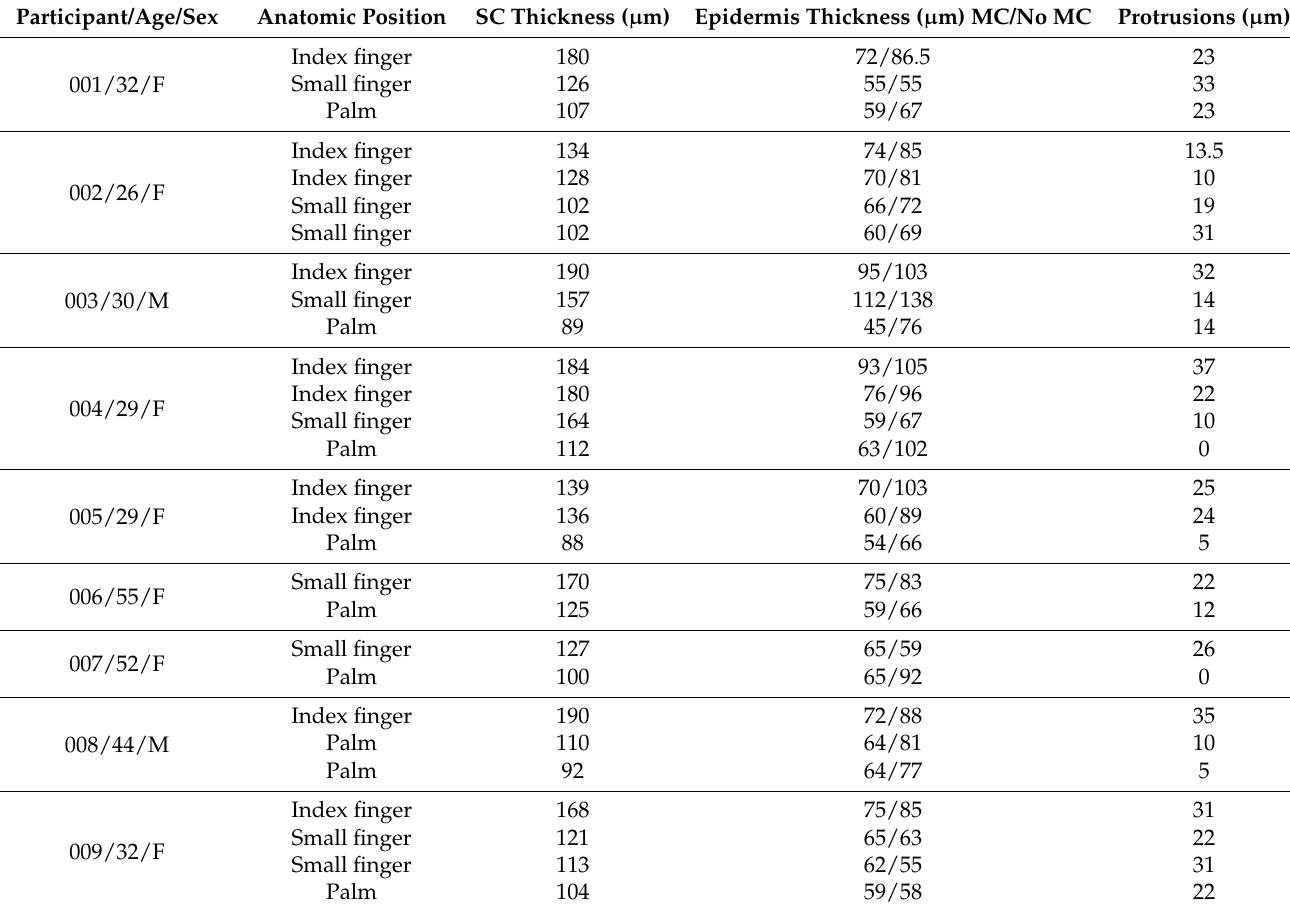
Table 1. Morphological information regarding the participants in this study. Above MCs, the thick-